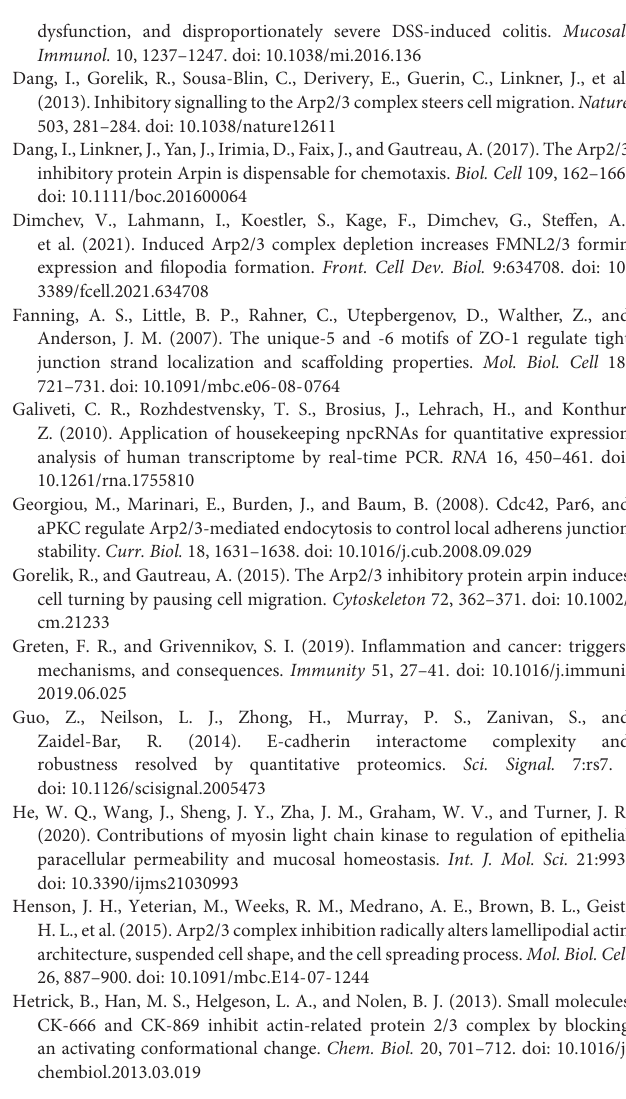
Supplementary Table 1 | Lists all primers. Supplementary Table 2 | Includes all primary and secondary